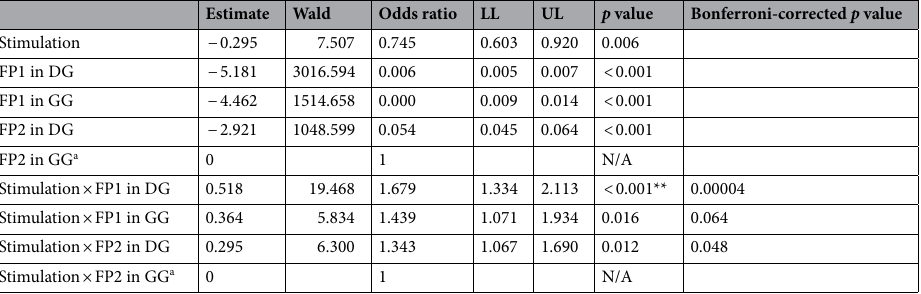
Table 2. Ordinal regression analysis (Model 2), showing the effect of stimulation in the FP1/FP2 trials in the dictator and generosity games. a Represents reference category; DG—dictator game; GG—generosity